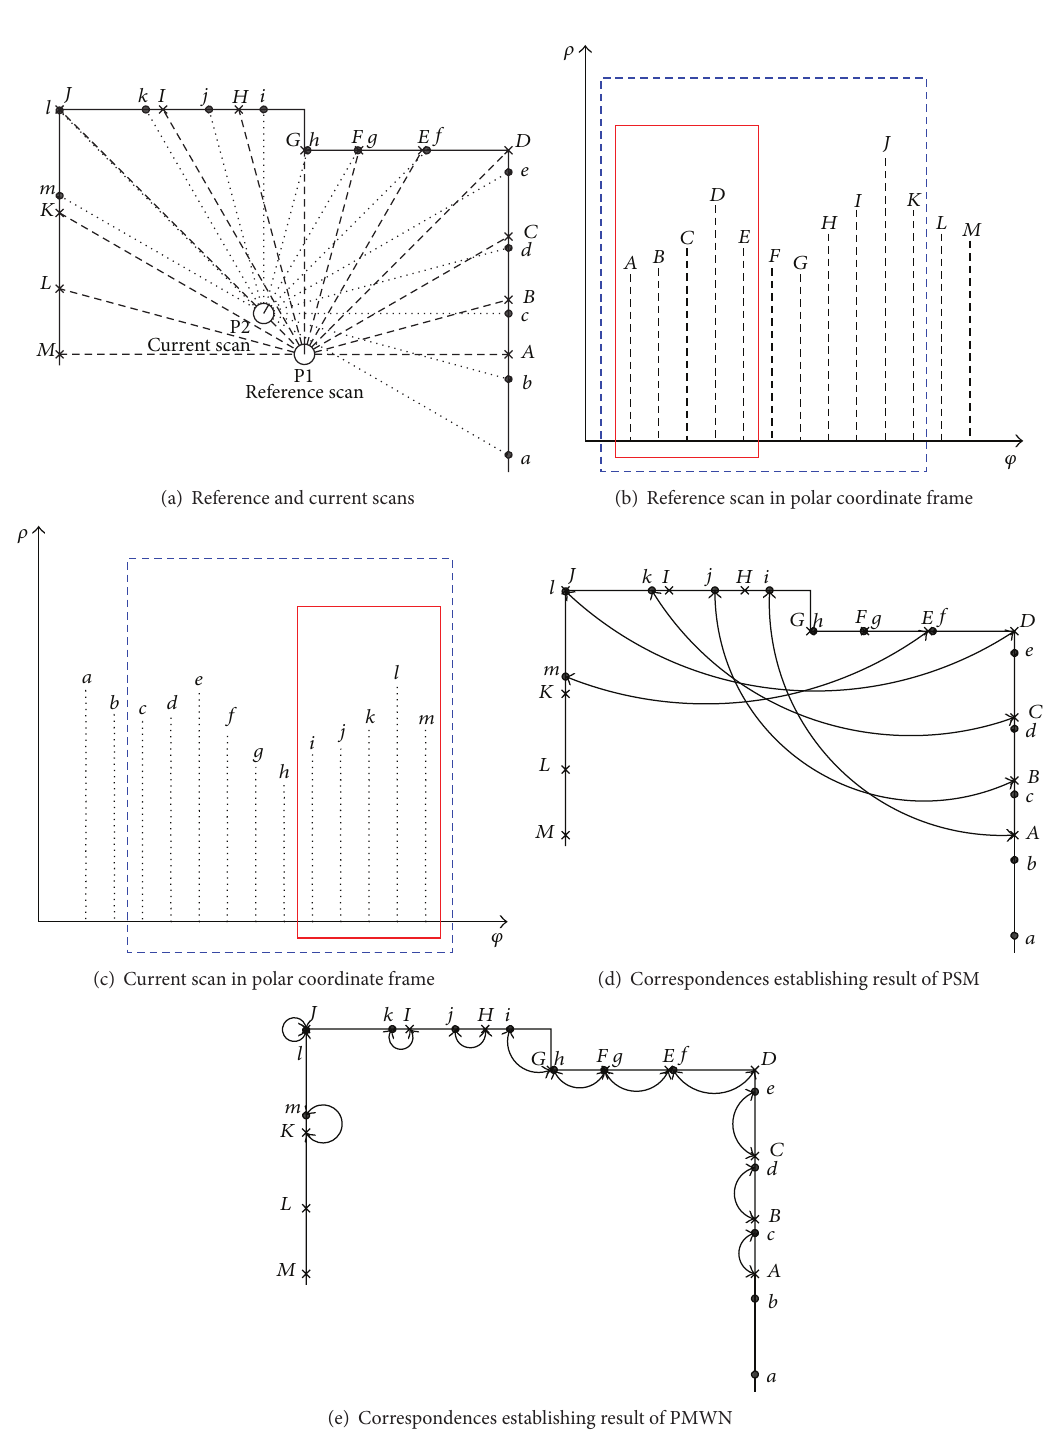
Figure 3: Correspondences establishment of PMWN and